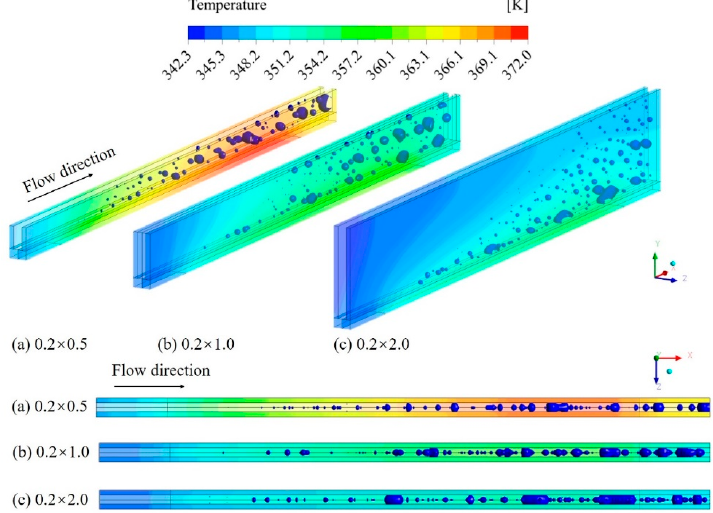
Figure 8. The quasi-steady-state solutions of temperature field and two-phase flow regime for different channel heights.